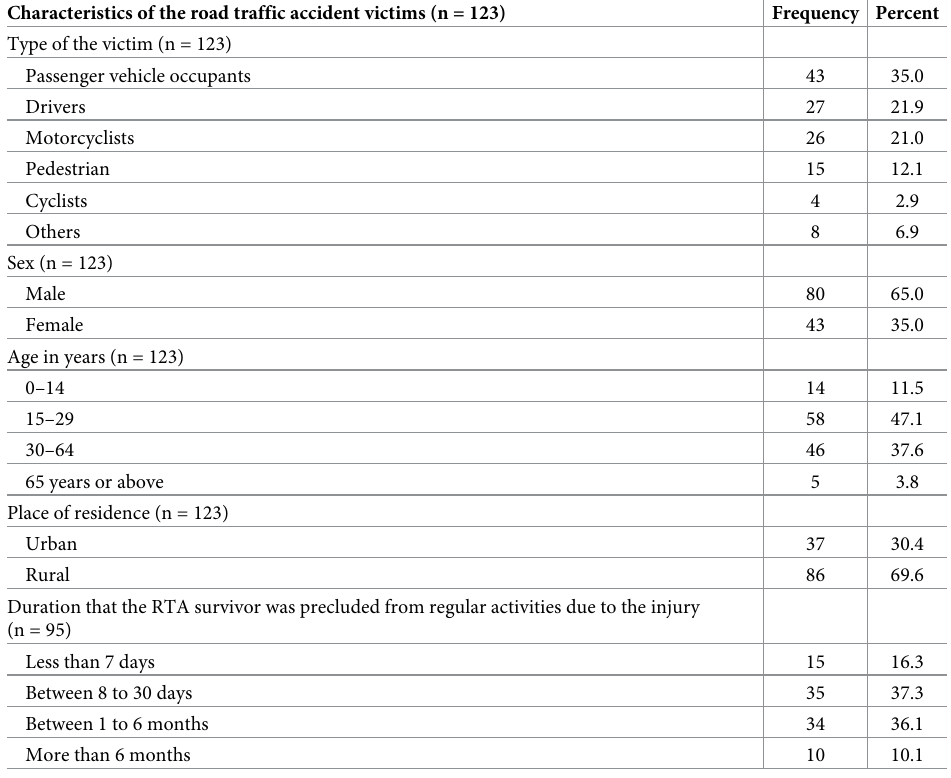
Table 2. Characteristics of the road traffic accident victims, Ethiopia,